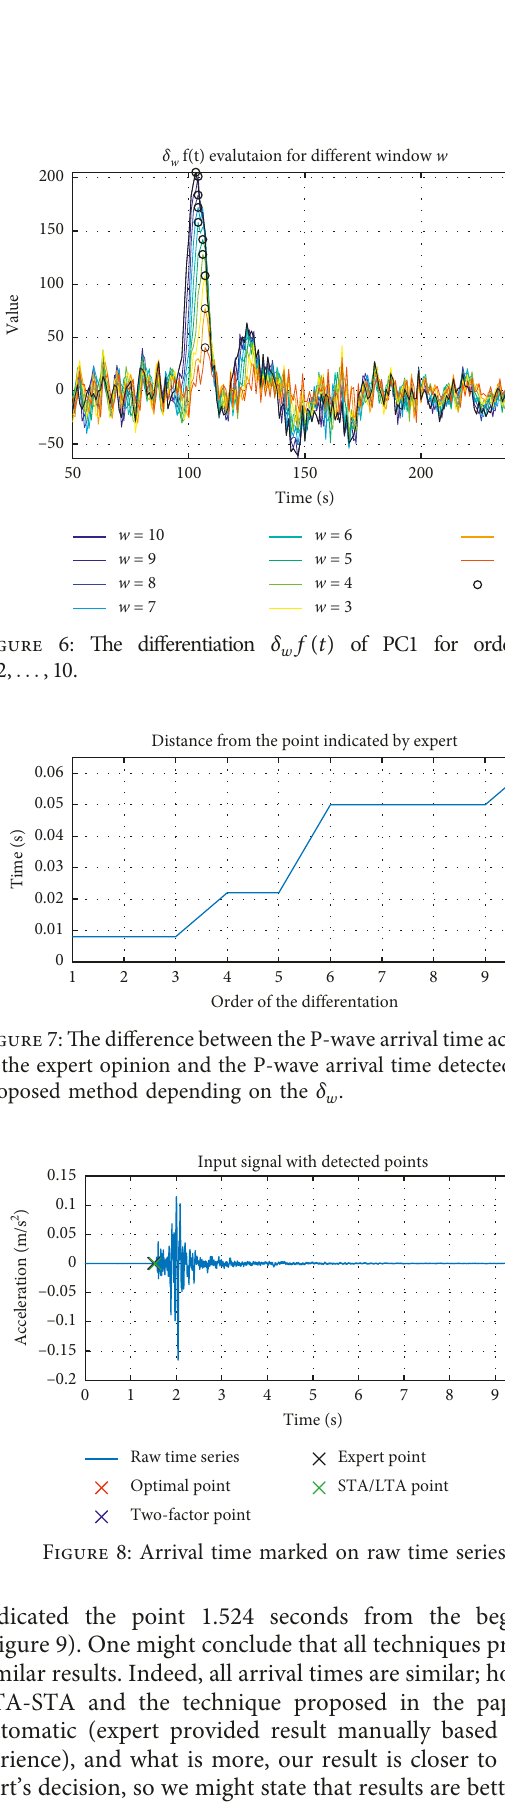
Figure 8: Arrival time marked on raw time